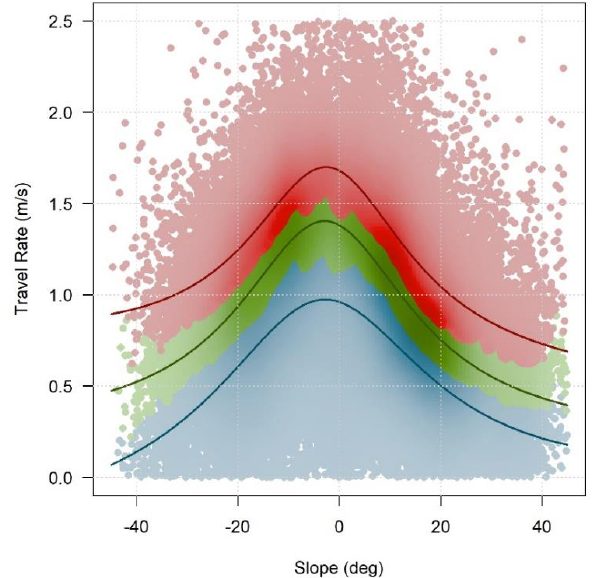
Figure 3. Filtered hiking travel rate data against slopes with the low, moderate, and high travel rate functions. Points are colored by model and shaded based on the density of points at a given location on the chart. Points and associated predictive function lines in the low tertile are colored blue, moderate tertile are colored green, and high tertile are colored red.